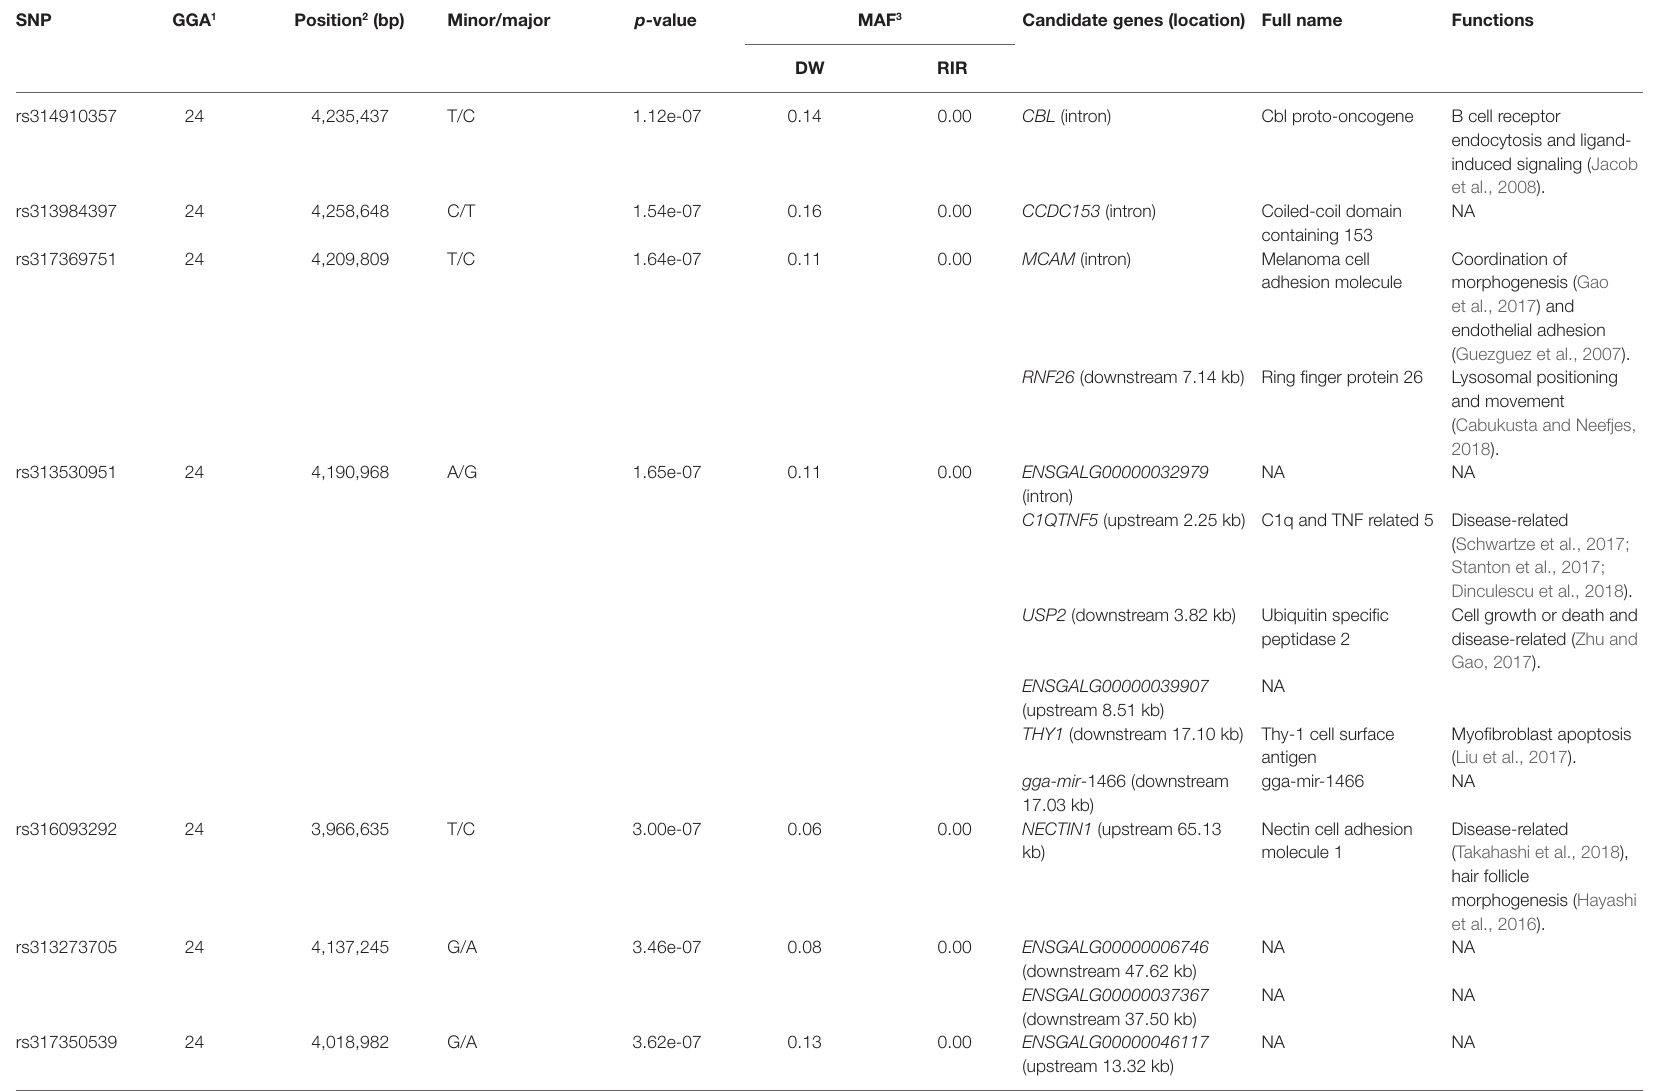
TABLE 2 | Single-nucleotide polymorphisms (SNPs) significantly associated with the tail feather color in the genome-wide association study (GWAS). SNP GGA 1 Position 2 (bp) Minor/major p